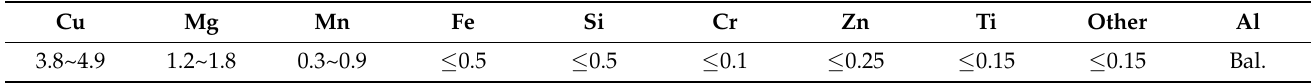
Table 1. Chemical composition of the 2024 aluminum alloy plates